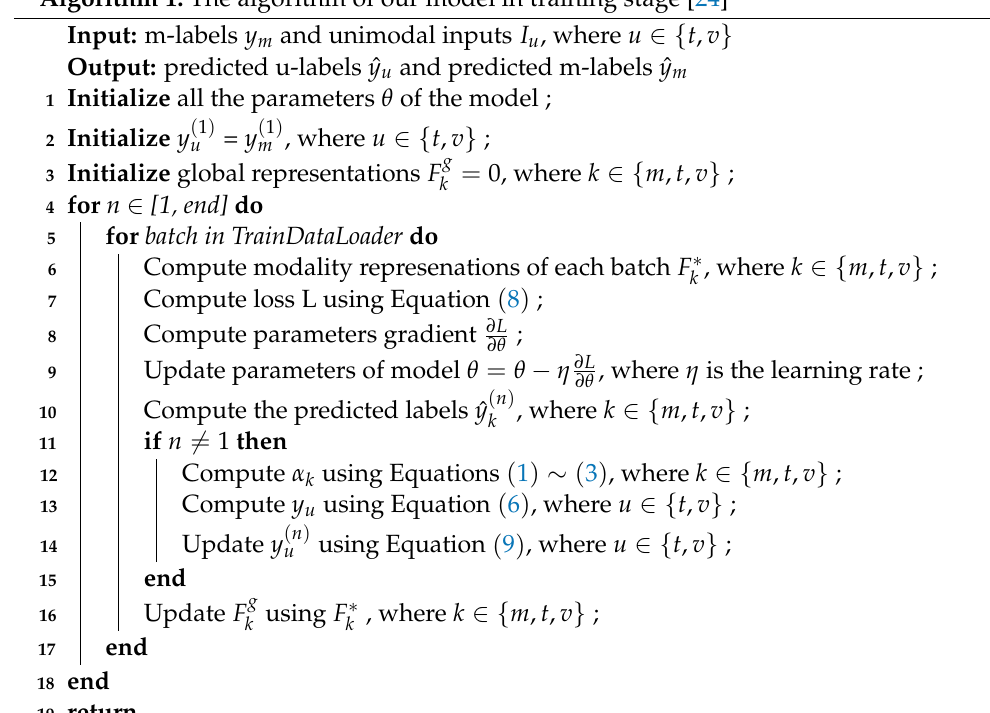
Algorithm 1: The algorithm of our model in training stage [24]